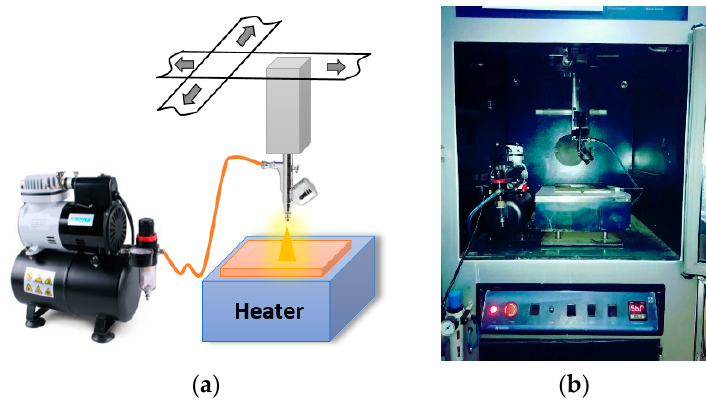
Figure 2. ( a ) schematic of the spray coating process and the aparatus. ( b ) picture of the Holmarc spray coating system, which accomodates the spray nozzle and the hotplate shown in ( a ).